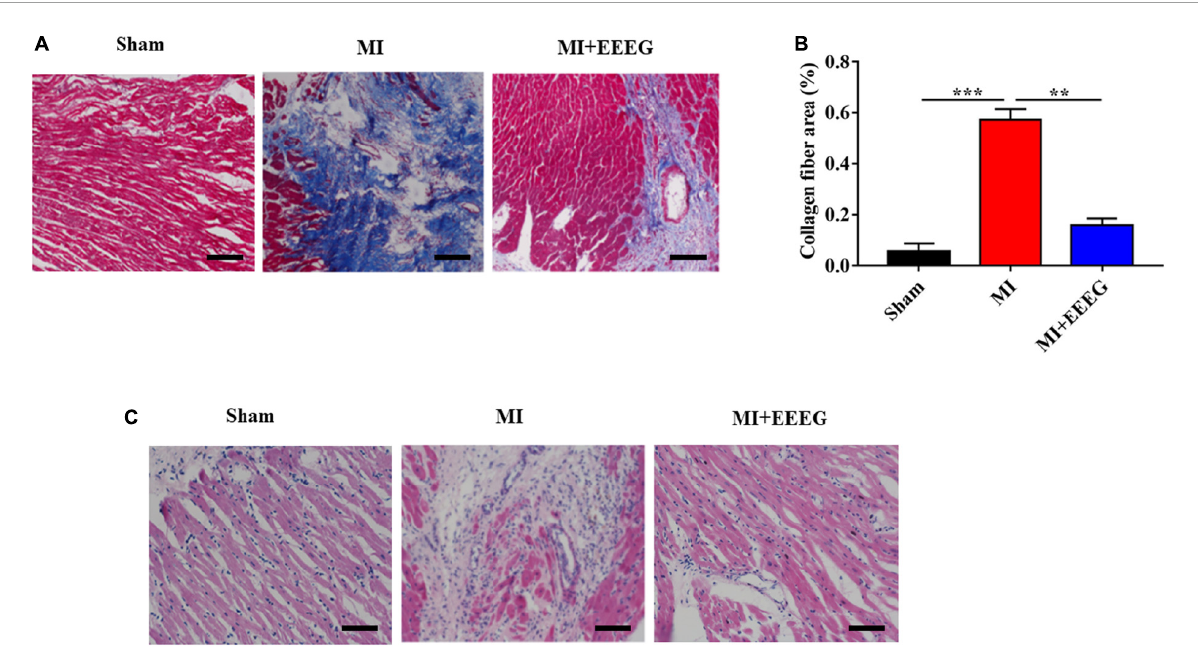
FIGURE2 EG extract (EEEG) alleviates fibrotic remodeling and histopathologic changes of cardiac tissue in response to MI. (A) Representative Masson’s trichrome-stained sections of vehicle and EEEG (10 g/kg) treated rat hearts 4 weeks after MI or sham operation (scale bar, 50 µ m). (B) Masson’s trichrome staining quantified the total cardiac fibrotic area using sections of vehicle and EEEG (10 g/kg) treated rat hearts at 4 weeks after MI or sham operation ( n = 8). (C) Representative H&E staining of heart tissue 4 weeks after MI or sham operation from rats treated with vehicle or EEEG (10 g/kg) (scale bar, 50 µ m). Data are mean ± SEM. ** P < 0.01, *** P <